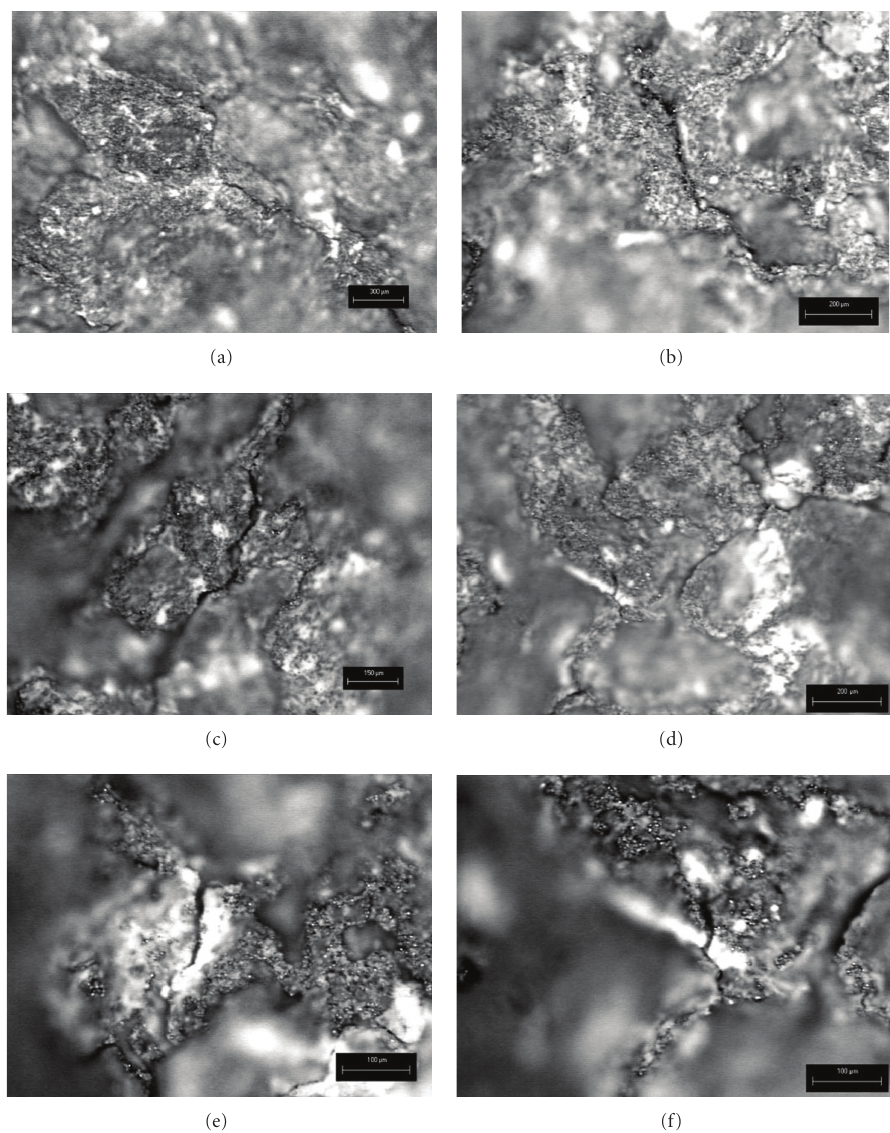
Figure 6: Micrographs of fracture surfaces of sintered nickel-alumina composites after mechanical